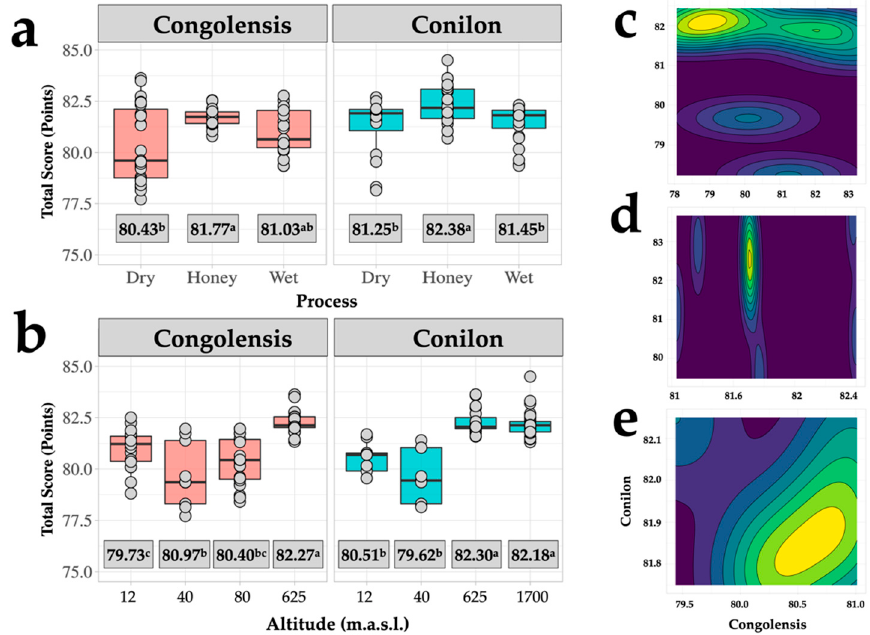
Figure 4. Total score of congolensis and conilon for ( a ) post-harvest processes; ( b ) altitudes. Contour plots of total scores for ( c ) dry; ( d ) honey; and ( e ) wet processes. Inside the Figure 4a,b, identical letters in superscripts indicate non-significant differences.